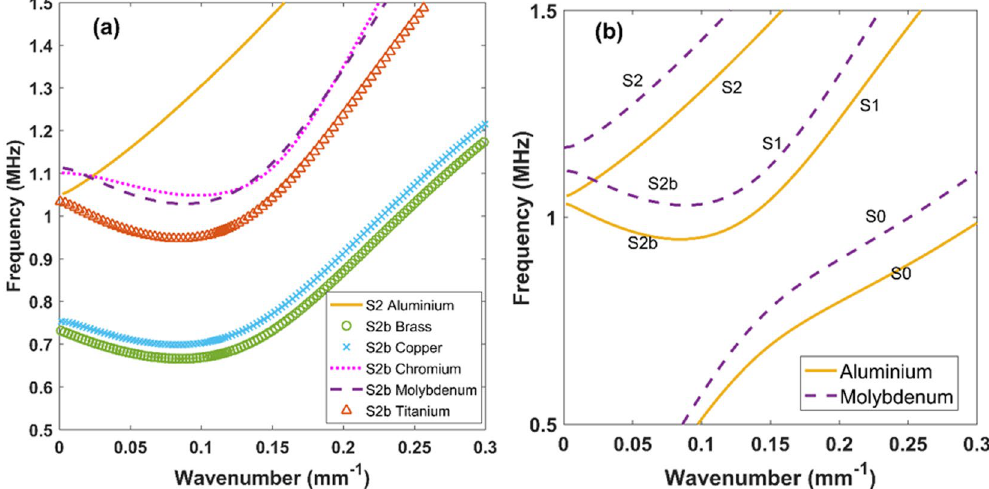
Figure 1. Lamb wave dispersion curves generated for a plate thickness of 3 mm. (a) Illustration of the S 2 mode of Aluminium and S 2b mode of the other materials. (b) Intersection of S 2 and S 2b mode of Aluminium and Molybdenum respectively at 1.09 MHz frequency.